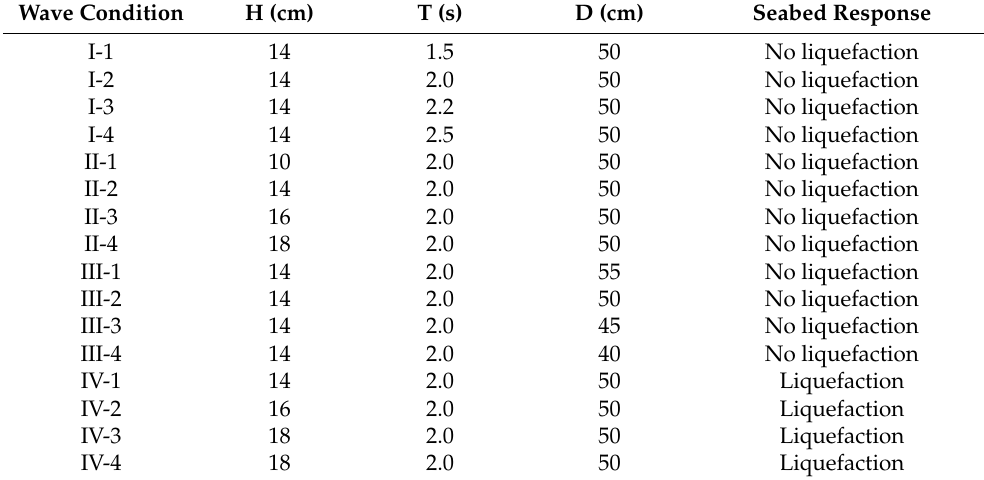
Table 2. Experimental wave